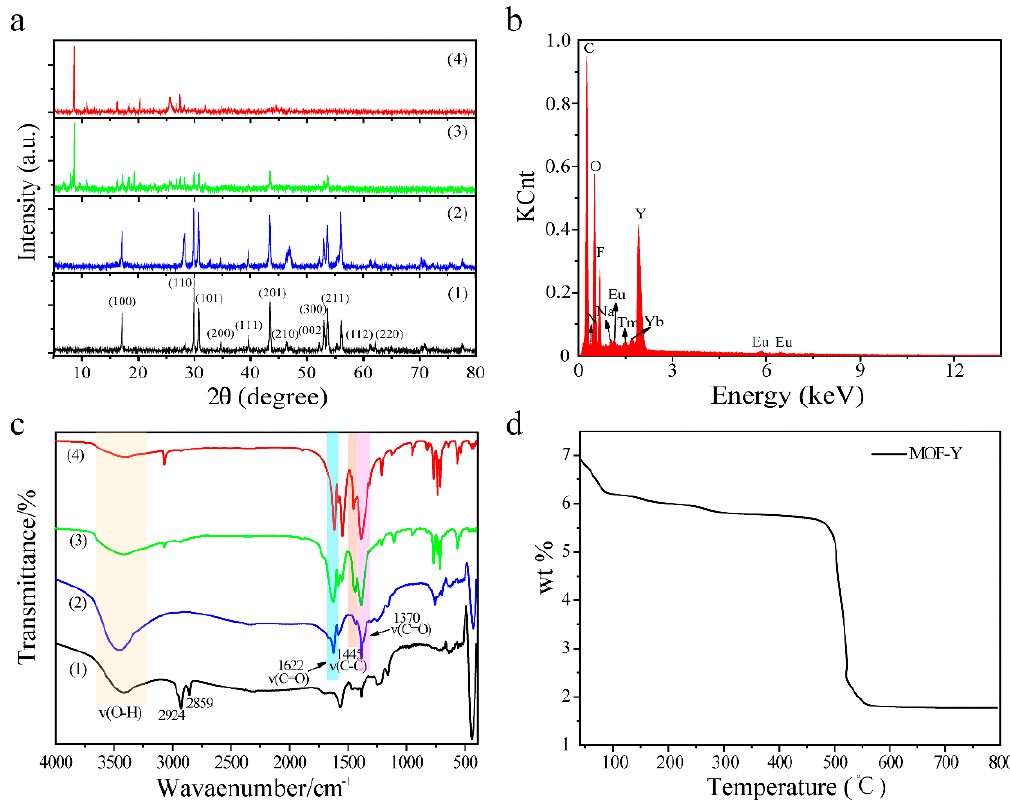
Figure 1. ( a ) XRD patterns of (1) NaYF 4 :Tm 3+ /Yb 3+ , (2) NYFT@MOFY-10 nanocomposites, (3) Figure